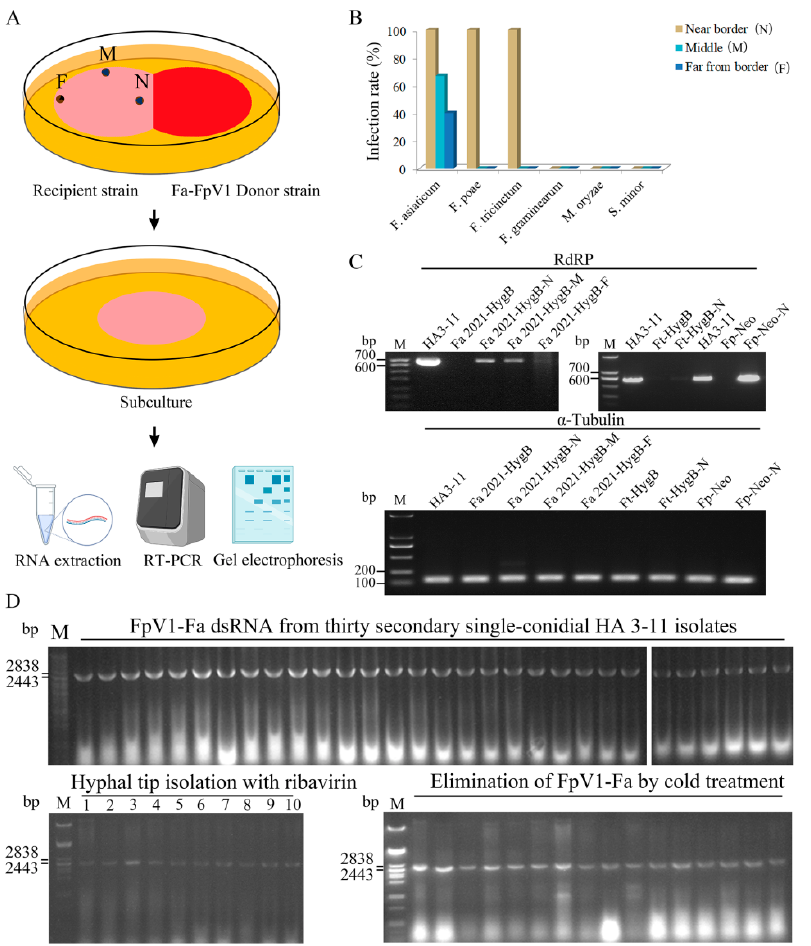
Figure 2. Viral transmission and stability analysis of FpV1-Fa. ( A ) Experimental procedure for investigating the horizontal transfer of FpV1-Fa from F. asiaticum to other fungi. F, far from border; M, middle; N, near border. ( B ) RT-PCR detection of FpV1-Fa infection from F. asiaticum to F. poae , F. graminearum , F. tricinctum , Magnaporthe oryzae and Sclerotinia minor . ( C ) The semi-quantitative RT-PCR detection of viral load in F. asiaticum and F. tricinctum. The α -tubulin gene is used to balance the overall RNA amount. ( D ) RT-PCR detection of the elimination of FpV1-Fa through conidia, cold treatment, and hyphal tipping with and without ribavirin. M, DNA marker.